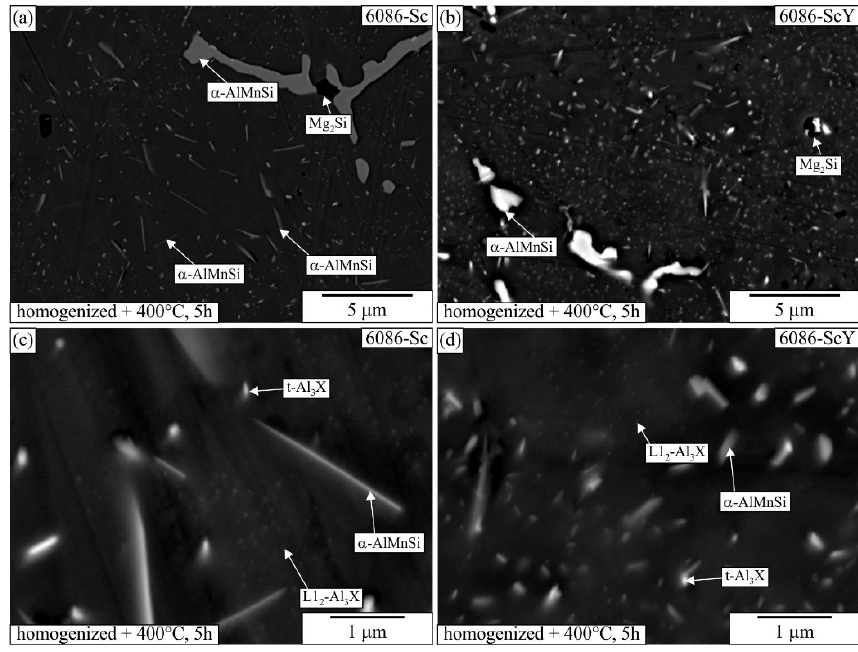
Figure 12. Backscattered electron micrographs of the alloys ( a , c ) 6086-Sc and ( b , d ) 6086-ScY after homogenization and holding for 5 h at 400 °C.